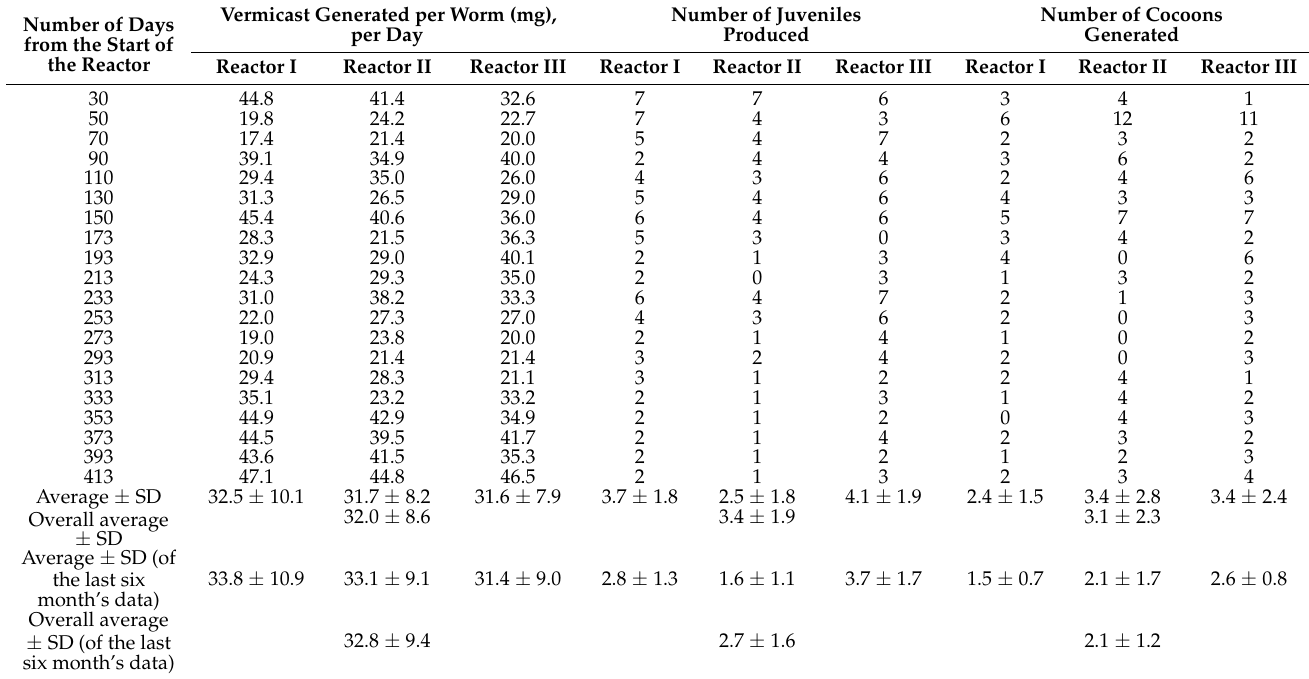
Table 10. Vermicomposting of ipomoea with 20 adults of E. fetida per kg of feed in pulse-fed modules.